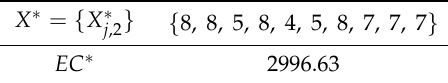
Table 7. Optimal release dates and cost in the case of assembly system (finished product is composed only of new complements). Table 8. Optimal release dates, optimal ordered date of used/end-of-life product and expected cost in the case of disassembly, remanufacturing, assembly system (finished product is composed of new and remanufactured complements).